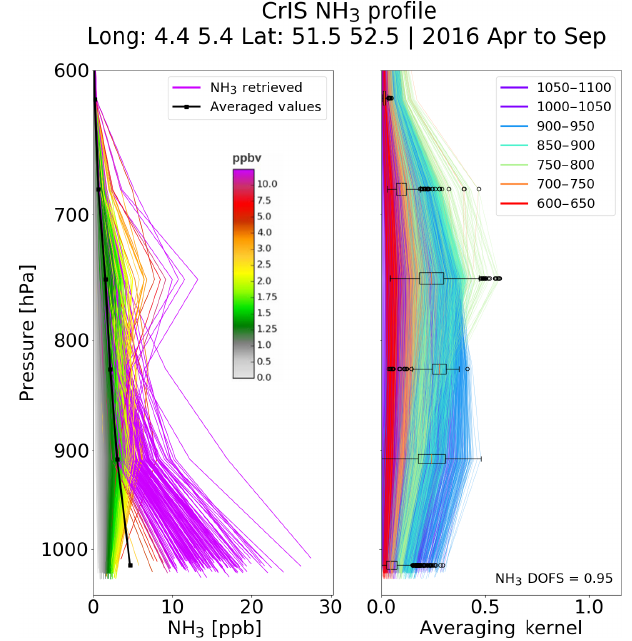
Figure 1. CrIS-retrieved NH 3 profiles from a 50km radius around Cabauw, the Netherlands, from April to September 2016. The re- trieved profile level values below 600hPa are shown in (a) and coloured according to the surface value, and the corresponding rows of the averaging kernels are shown in (b) . The box and whiskers showing the statistics (e.g. median, percentiles, and outliers (cir- cles)) of the rows of the averaging kernel values at each retrieval level are also provided on the averaging kernel